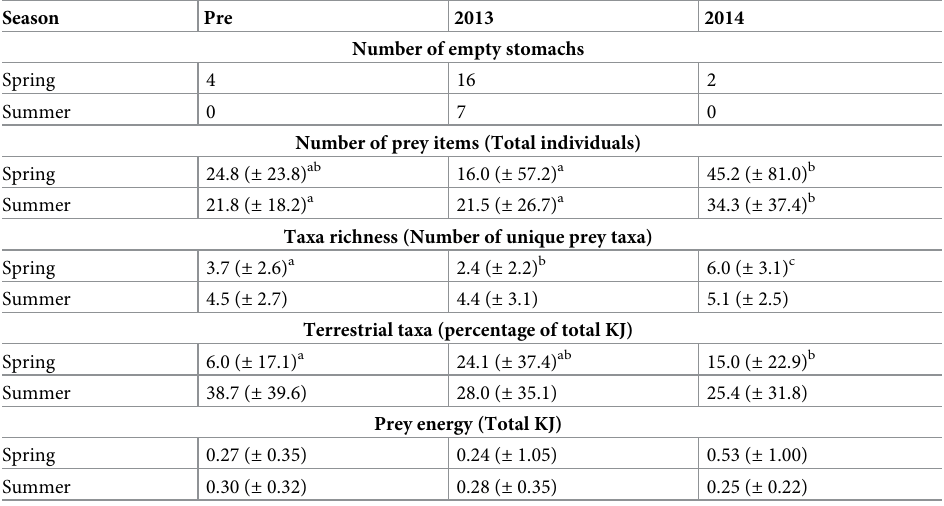
Table 6. Univariate diet metrics (means ± 1 SD) for coho and Chinook juvenile salmon collected in the